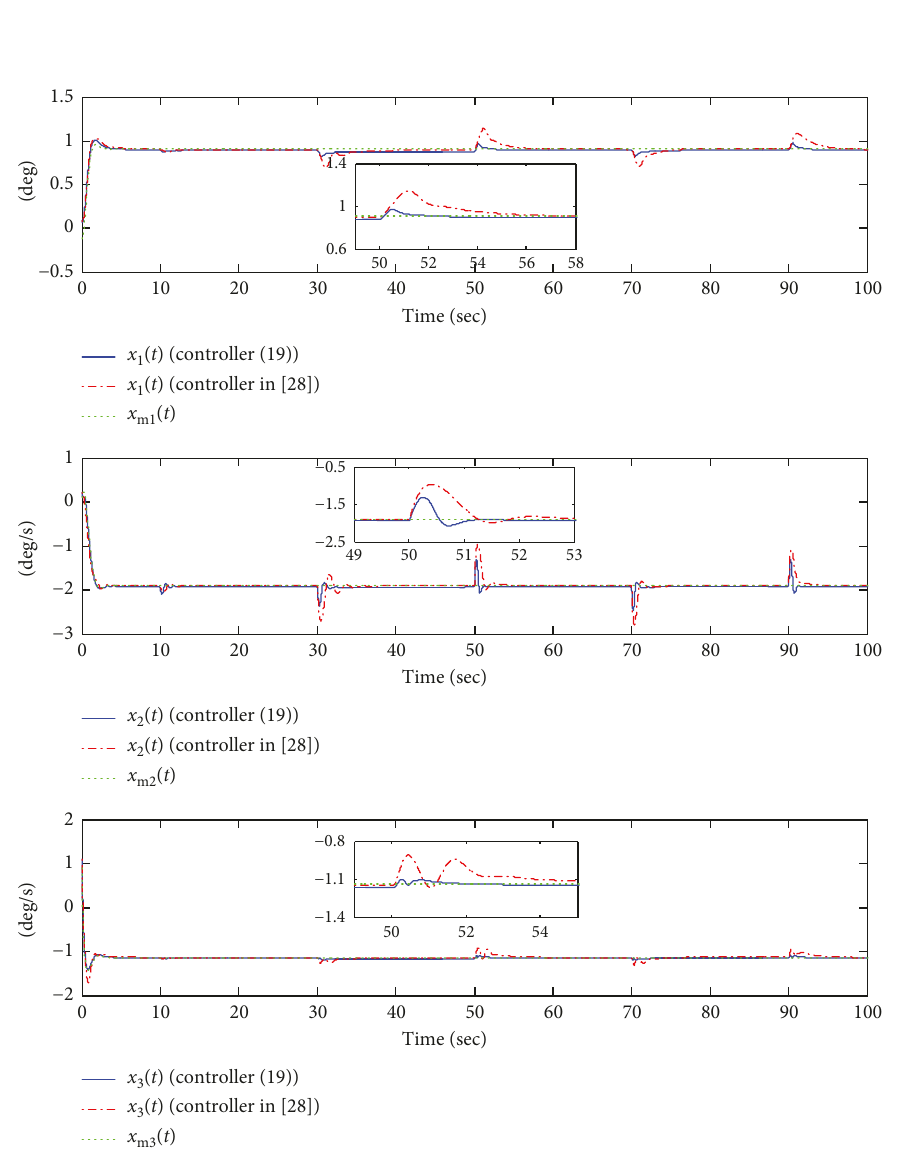
Figure 1: Trajectories of plant state x ( t ) and reference model state x